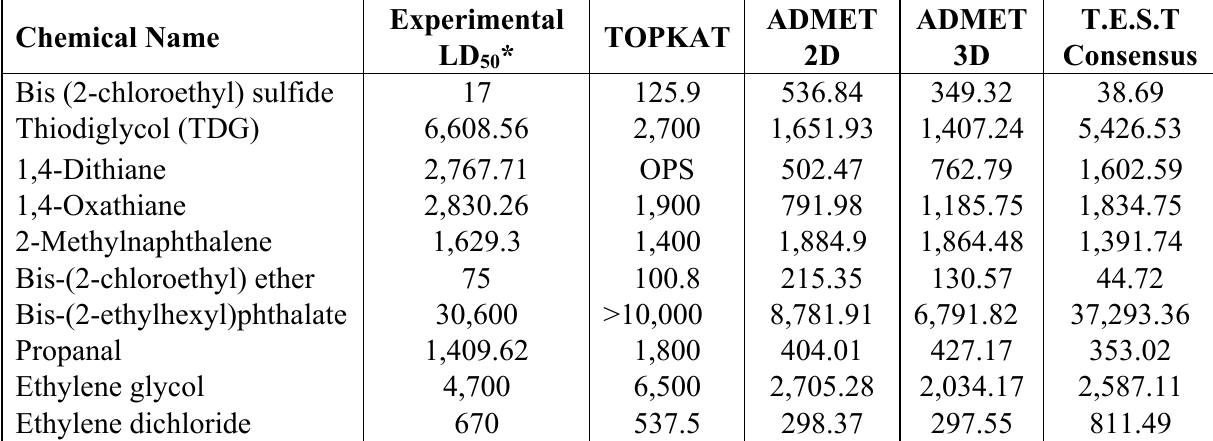
Table 2. Comparison of the estimated LD predictor, and the T.E.S.T model for chemicals with available experimental